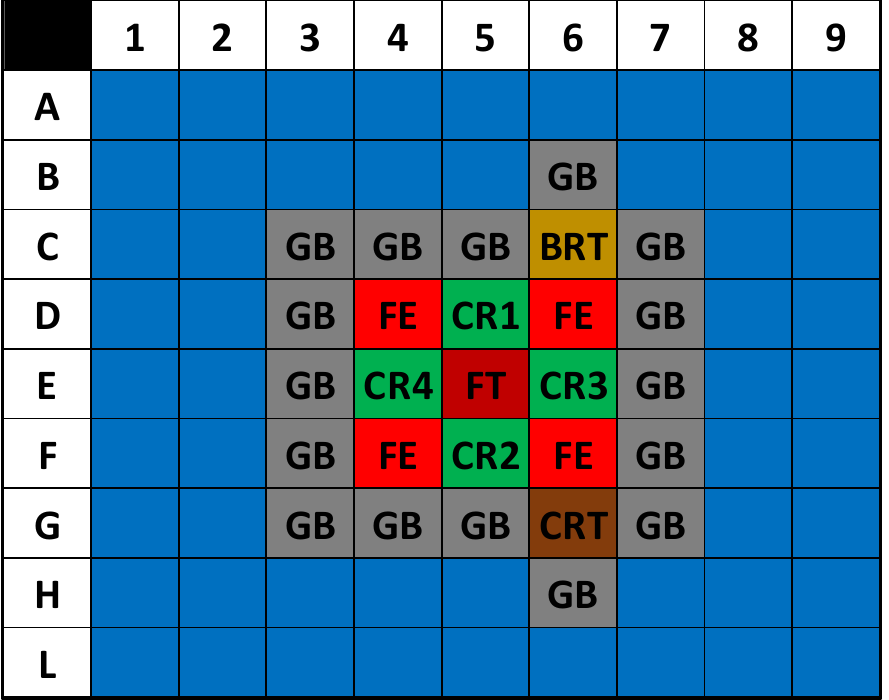
Figure 3. The proposed MSTR high-power core configuration. GB: Graphite Block; FE: Fuel Element; CR#: Control Rod; BRT: Bare Rabbit Tube; CRT: Cadmium Rabbit Tube; FT: Flux Trap.